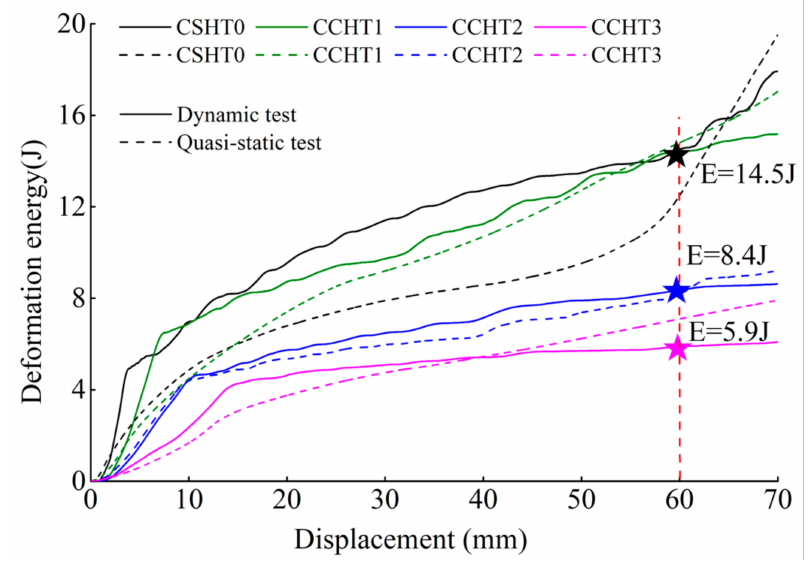
Figure 19. The comparison of deformation energy between dynamic and quasi-static compressive tests for CSHT0, CCHT1, CCHT2, and CCHT3.